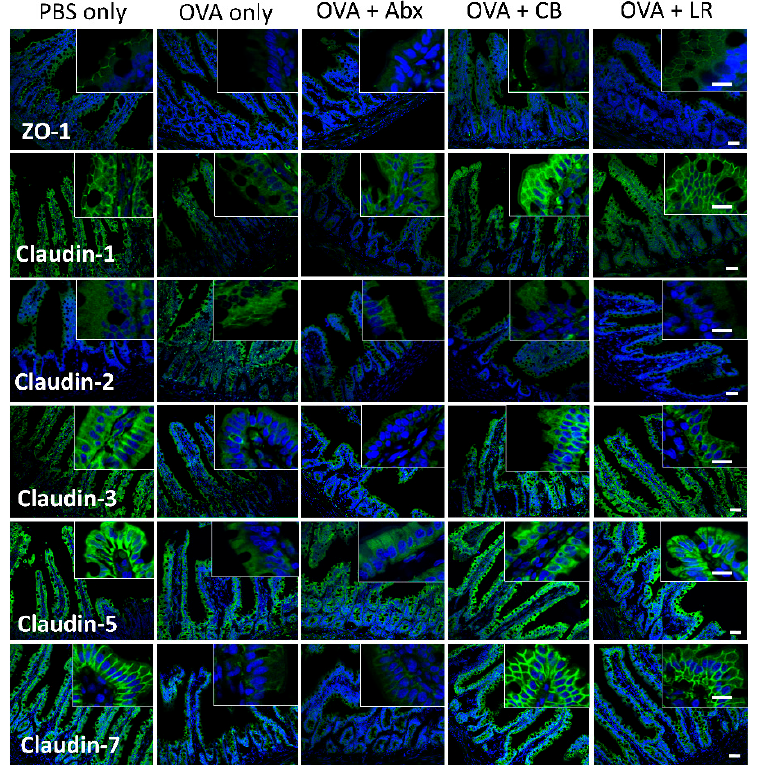
Figure 6. Representative confocal images of TJ-related proteins. Cryosections of the jejunal tissue were immunolabeled for ZO-1 and claudin-1, -2, -3, -5, and -7 (in green). Nuclei were visualized with DAPI (in blue). Size bars, 50 µ m (small) and 20 µ m (large). Abx, antibiotics; CB, C. butyricum ; LR, L. reuteri .